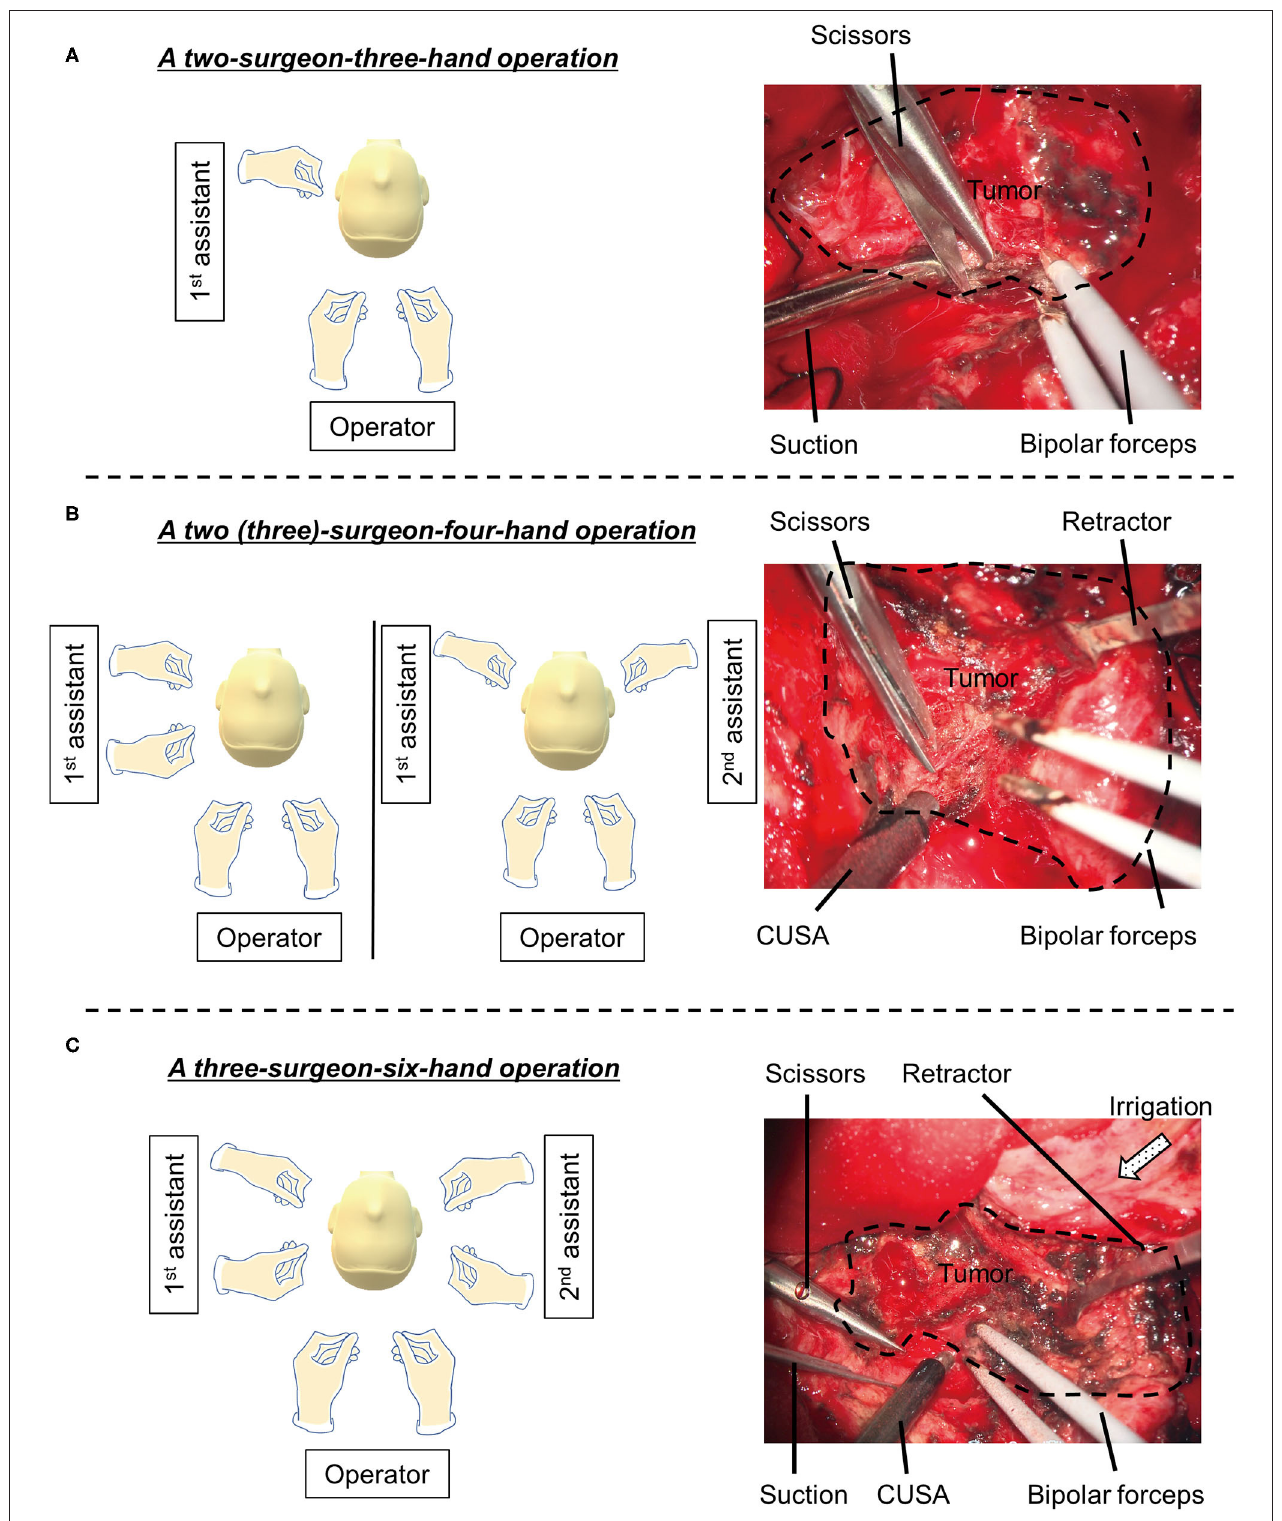
FIGURE 3 | The combination of the experienced operator and assistants. A two-surgeon-three-hand (A) , a two (three)-surgeon-four-hand (B) and a three-surgeon-six-hand operations (C) is illustrated on the left panels. Intraoperative images are shown on the right panels.